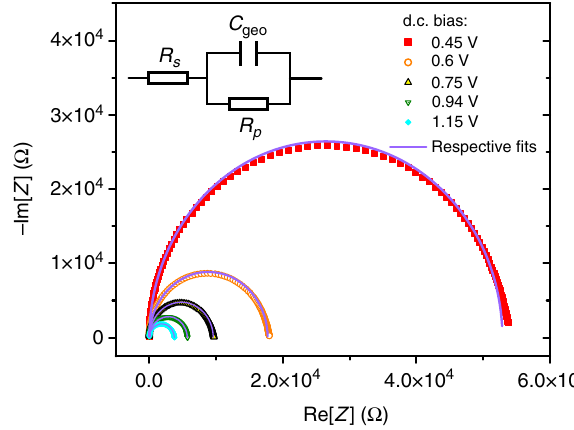
FIG. 22. “ Unconstrained ” (see surrounding text for clarifica- tions) semicircle fits to the low-voltage data series of the 135-nm HMW PFO β -embedded hole-only device, using the simpli- fied Randles equivalent circuit (schematic provided as the figure